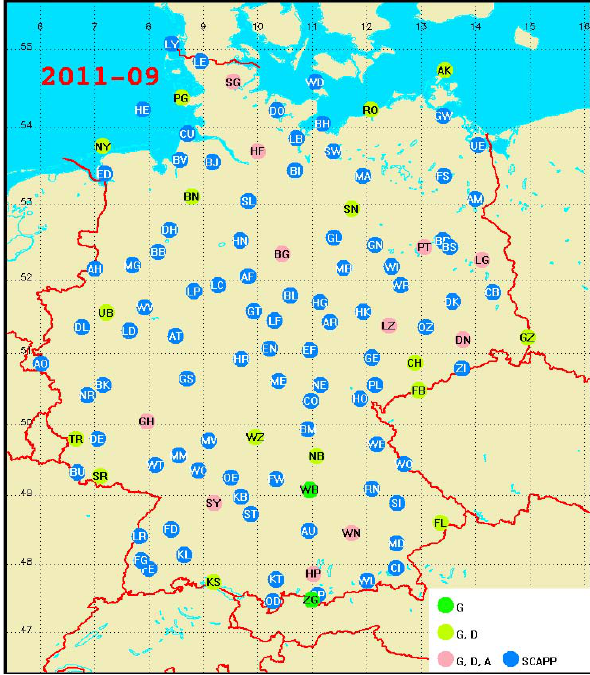
Figure 2. Ground based network for irradiance measurements, lo- cation and characterisation of sites. Green circles indicate short- wave total (G) and di ff use (D) component measured by pyranome- ters, pink indicates the same plus atmospheric longwave radia- tion (A). Blue: sites equipped with